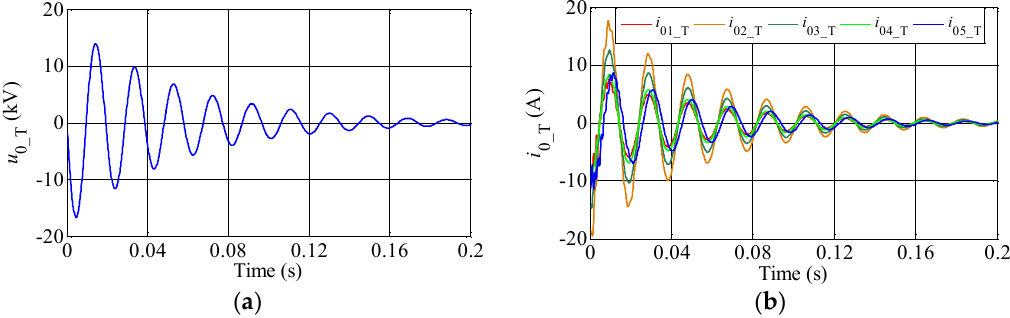
Figure 7. Transient components of bus zero-sequence voltage and feeders’ zero-sequence currents for a single-phase HIF in K4 point. ( a ) Transient component of bus zero-sequence voltage; ( b ) Transient components of feeders’ zero-sequence currents.